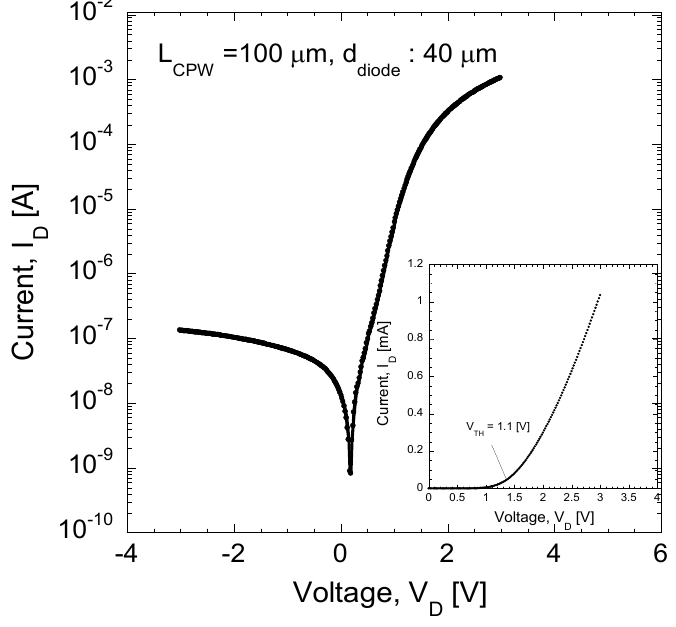
Figure 2. DC I-V curve of fabricated Schottky